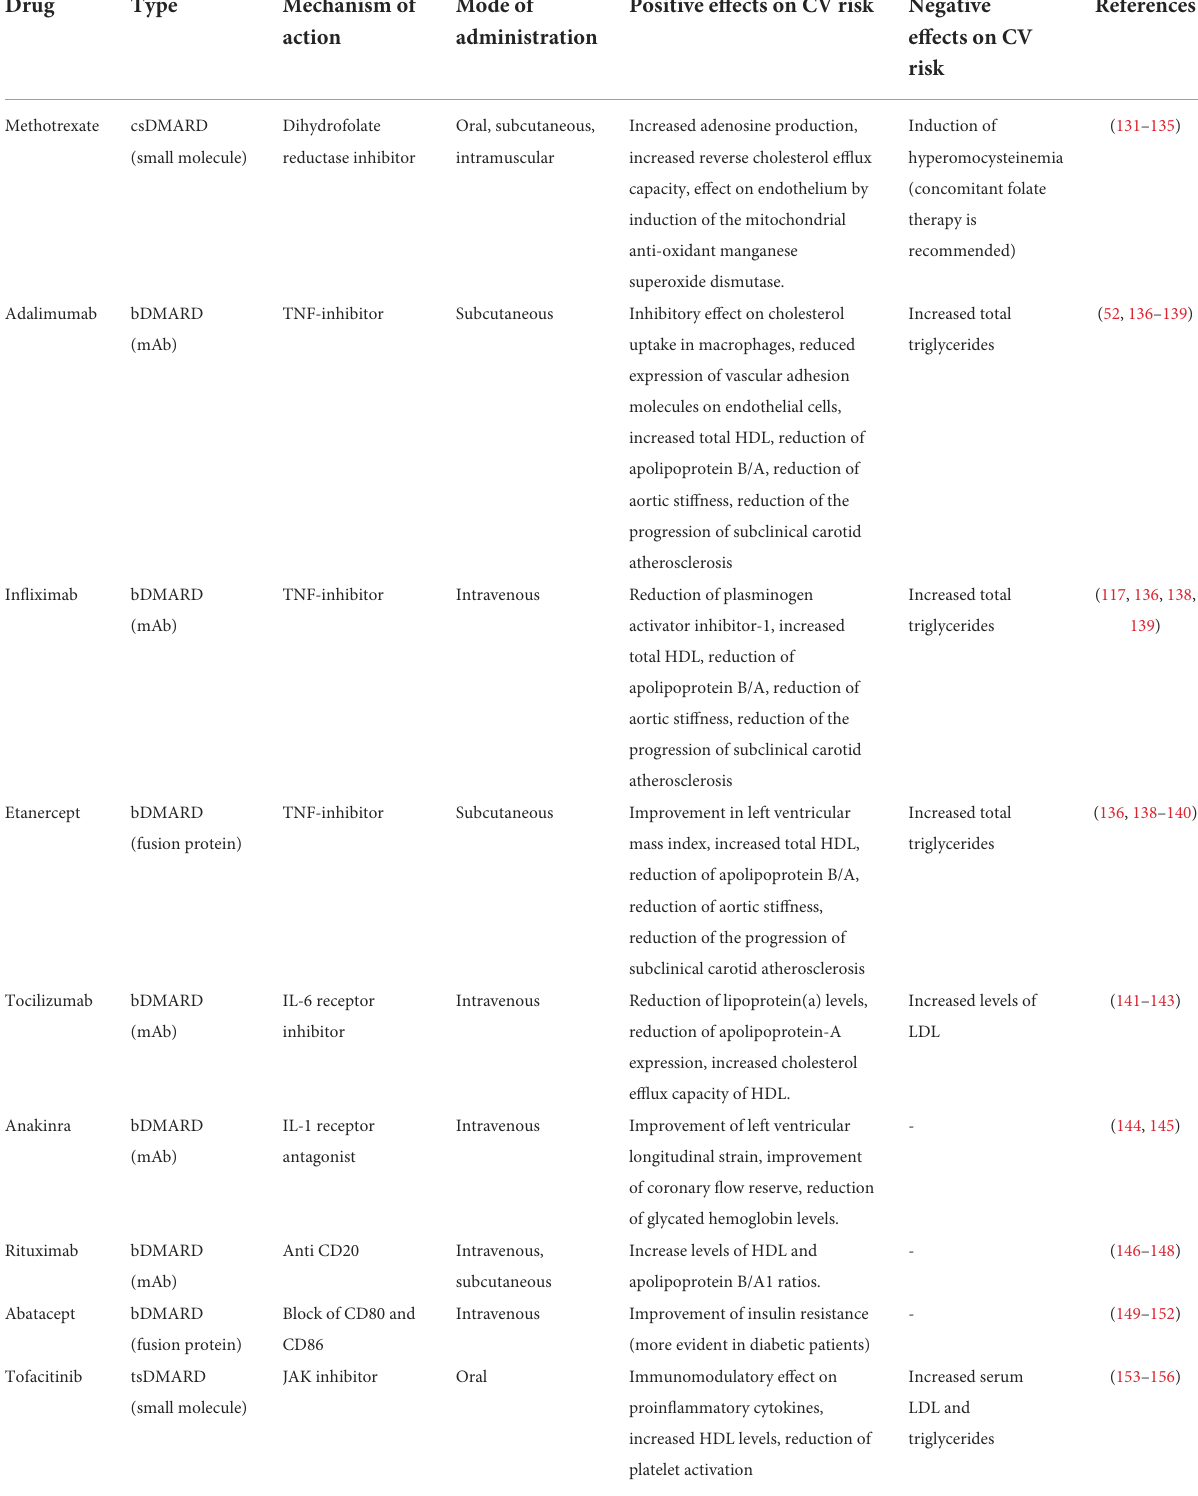
TABLE 1 Disease-modifying anti-rheumatic drugs (DMARDs) commonly used in patients with rheumatoid arthritis and their potential effects on cardiovascular risk.